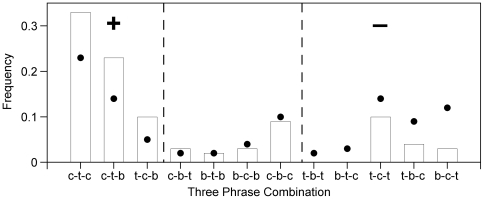
Observed and expected three-phrase combination frequencies.Observed frequencies (bars) and expected frequencies (circles) from the first-order model of three phrase combinations without trill or buzz repeats. “c” = chirp, “t” = trill and “b” = buzz. Combinations to the left of the dashed line occurred more frequently than expected (labeled with +) while combinations to the right of the dashed line on the right occurred less frequently than expected (labeled with –). Only songs with greater than three phrases were included (N = 183 songs, 302 total transitions).